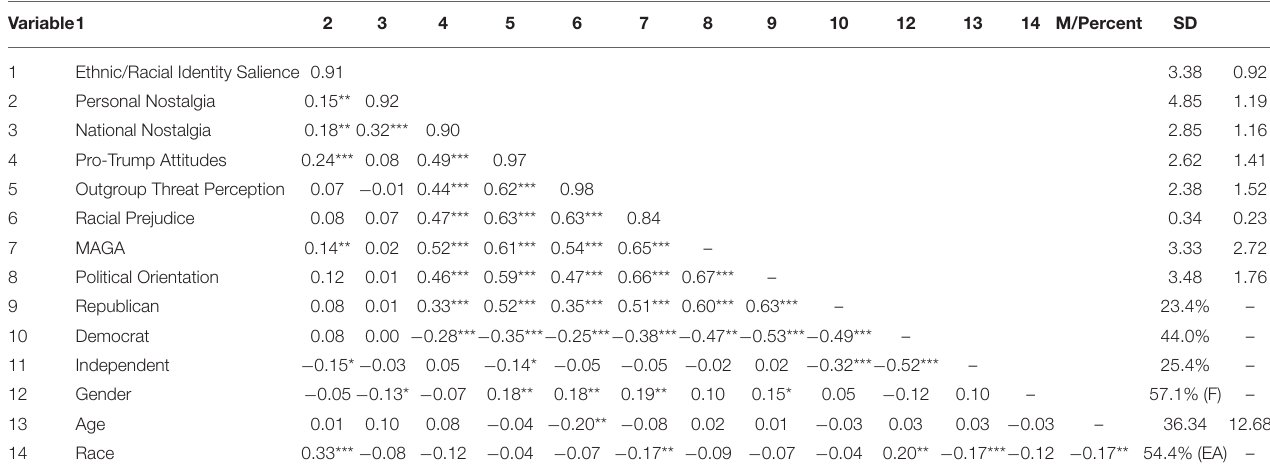
TABLE 1 | Descriptive statistics and bivariate correlations among study variables.